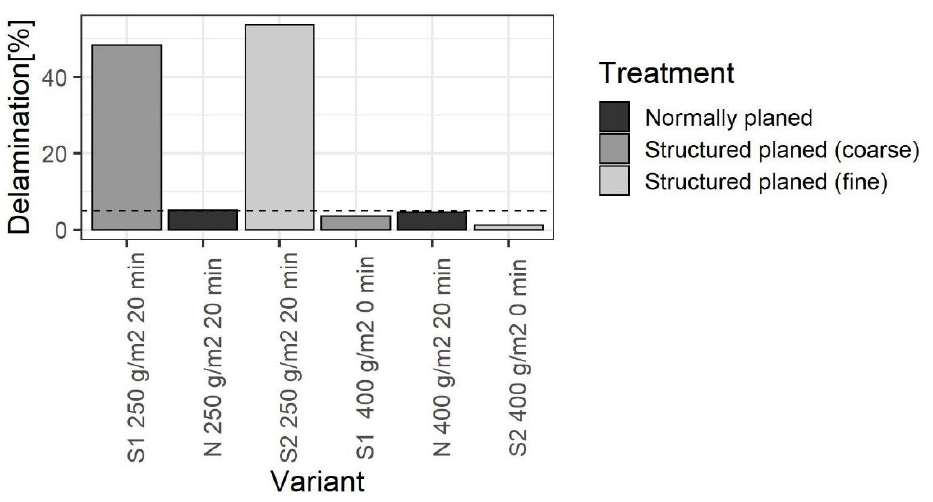
Figure 6. Delamination results for one-component polyurethane without chemical pre-activation treatment of hardwood. The bars represent the arithmetic mean value; the dashed line shows the maximum value of delamination accepted according to the employed standard.